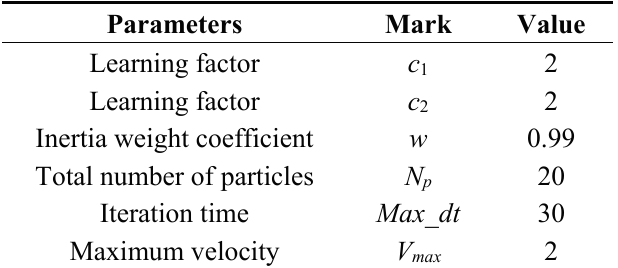
Table 4. The simulation parameters of D-PSO algorithm.